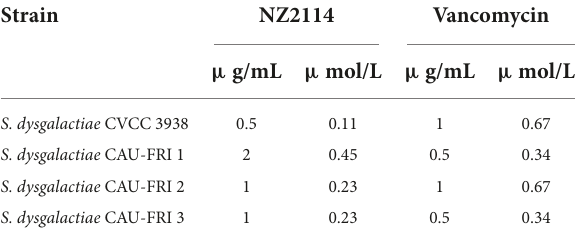
TABLE 2 The MIC values of NZ2114 against S. dysgalactiae. Strain